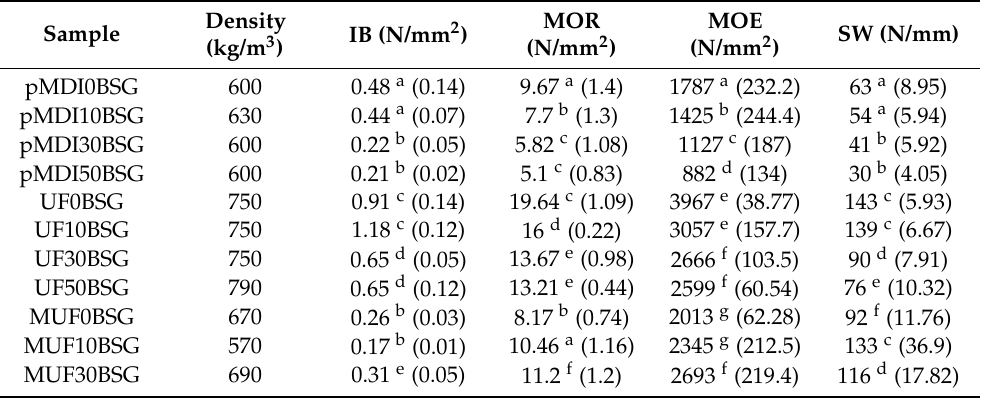
Table 3. Results of the physical and mechanical properties of the 15 mm particleboards (a, b, c, d, e, f, g values with the same letter are not significantly different: ANOVA, Post-Hoc Tukey HSD, α =